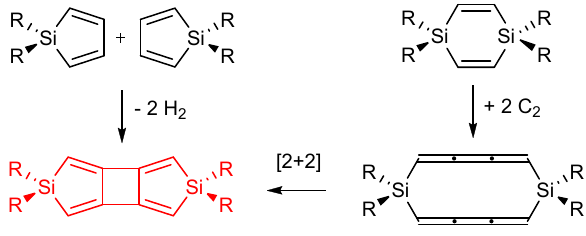
Figure 13. Formal relationship showing how siloles and 1,4-disilacyclohexa-2,5-dienes are linked with cyclobutadisiloles (in red).